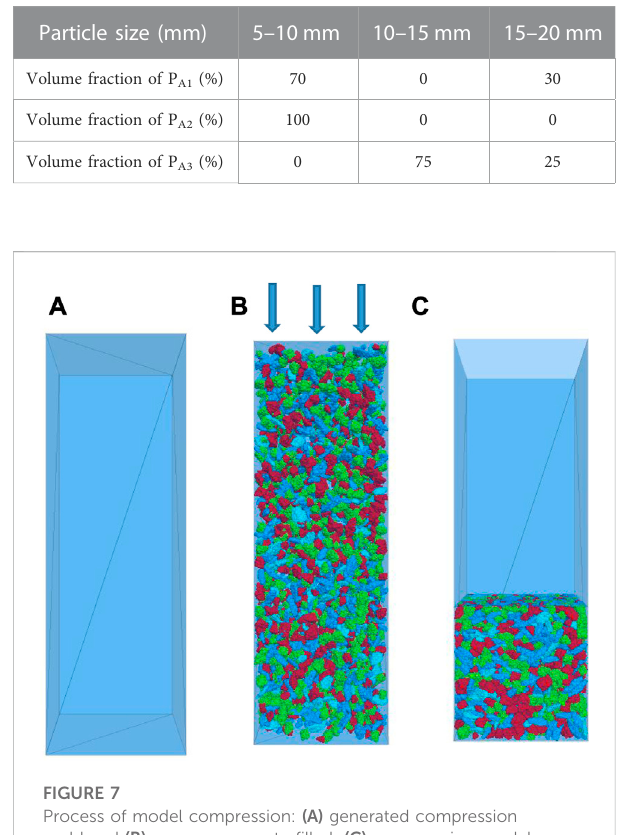
FIGURE 7 Process of model compression: (A) generated compression mold and (B) coarse aggregate fi lled; (C) compression